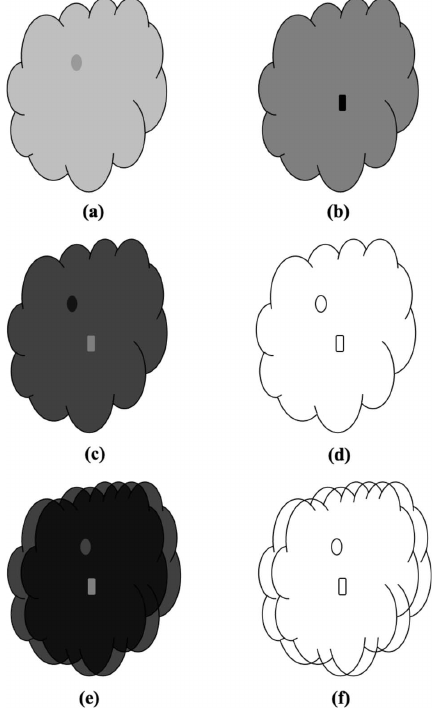
Figure 1 Schematic illustration of the proposed TVDM principle for aligning similar images. Panels ( a ) and ( b ) show the target and source images I t and I s . ( c ) I t (cid:3) I s when two images are aligned. It has non-zero background since the gray scales of I t and I s are not calibrated. ( d ) Gradient map of ( c ). The non-zero background is removed from the gradient operation, so only edges are reserved. ( e ) I t (cid:3) I s when two images are not aligned. ( f ) Gradient map of ( e ). The number of edge points is doubled compared with that in ( d